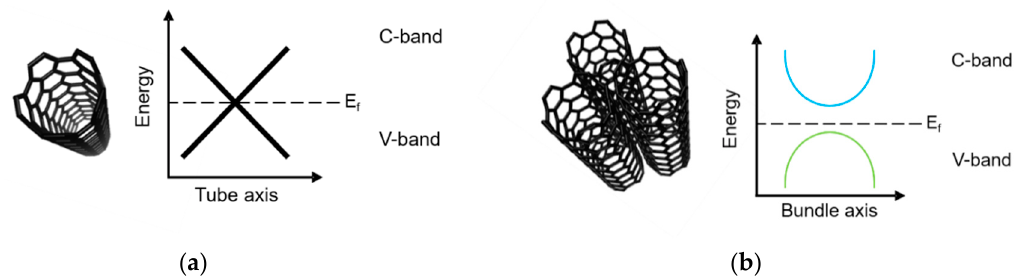
Figure 1. Energy band structures for an isolated SWCNT in vacuum ( a ) and a bundle of SWCNTs in vacuum ( b ) (according to [24]).